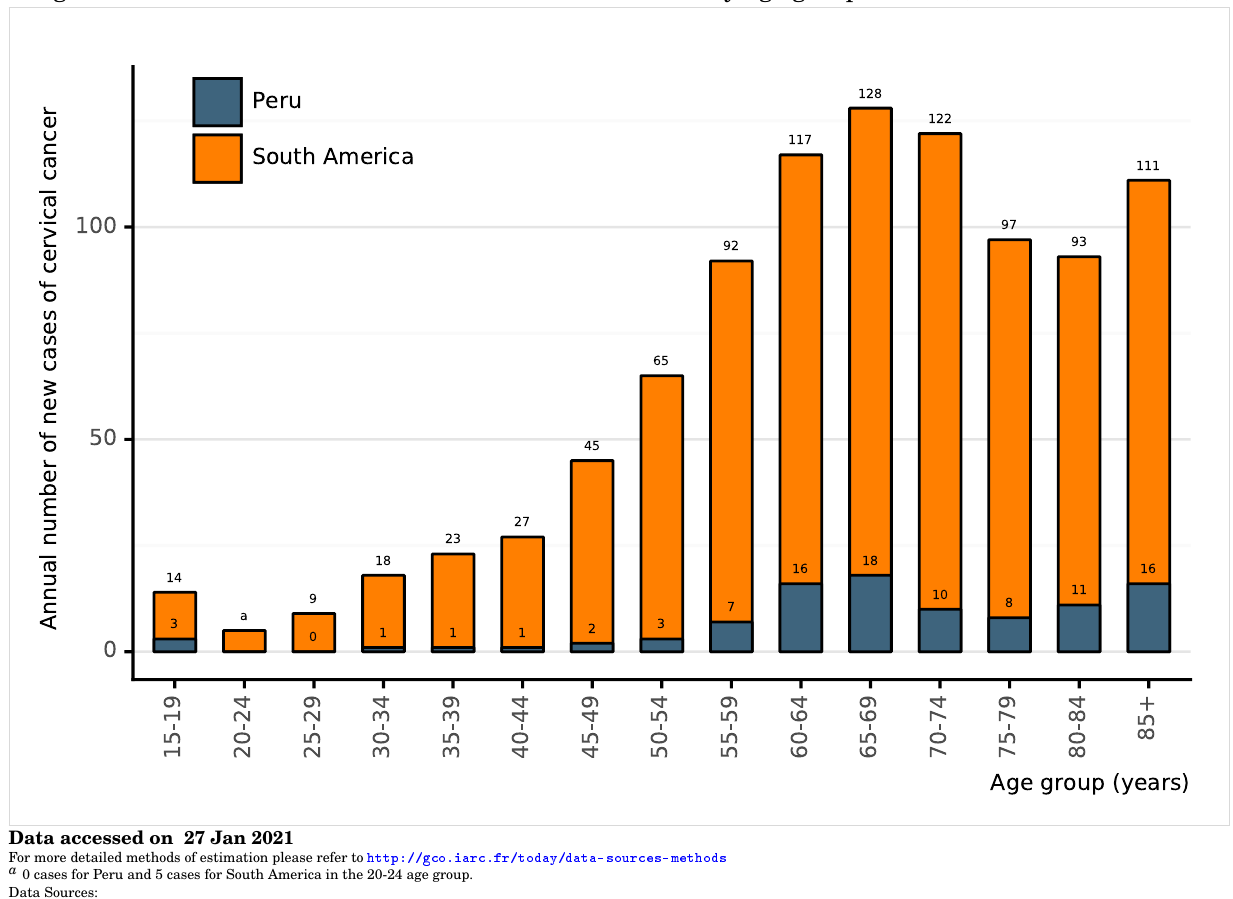
Figure 85: Annual number of new cases of cervical cancer by age group in Peru (estimates for